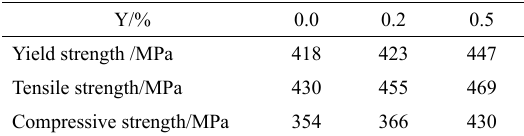
Figure 3. The microstructure of the Zn-1.5Mg-xY alloys (a) (d)—Zn-1.5Mg alloy, (b) (e)—Zn-1.5Mg-0.2Y alloy, (c) (f)—Zn-1.5Mg-0.5Y alloy. Table 2. The strength changes of Zn-1.5Mg-xY alloys with different Y